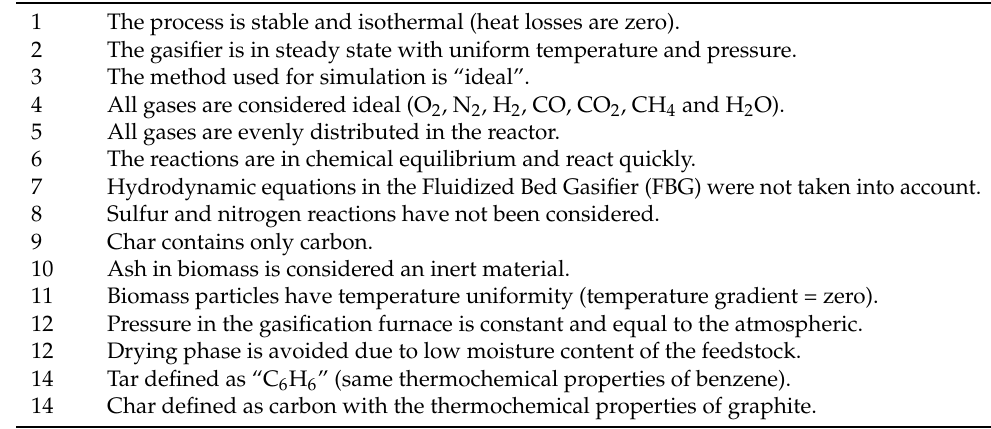
Table 2. Model’s hypotheses and